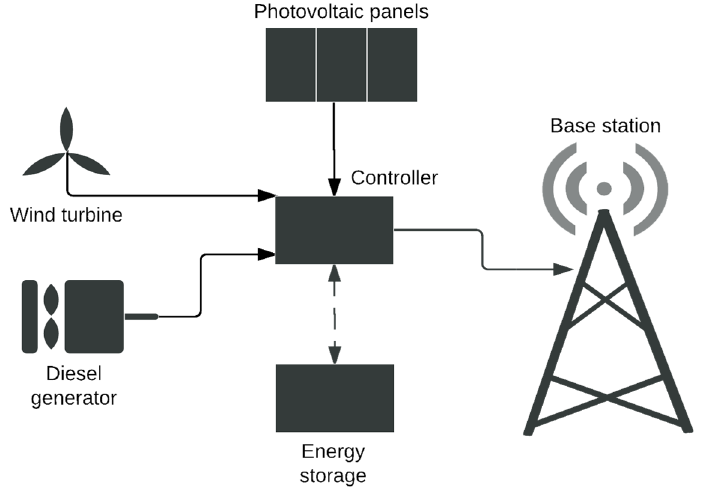
Figure 4. Typical configuration of a hybrid PV-wind-diesel system in a base station